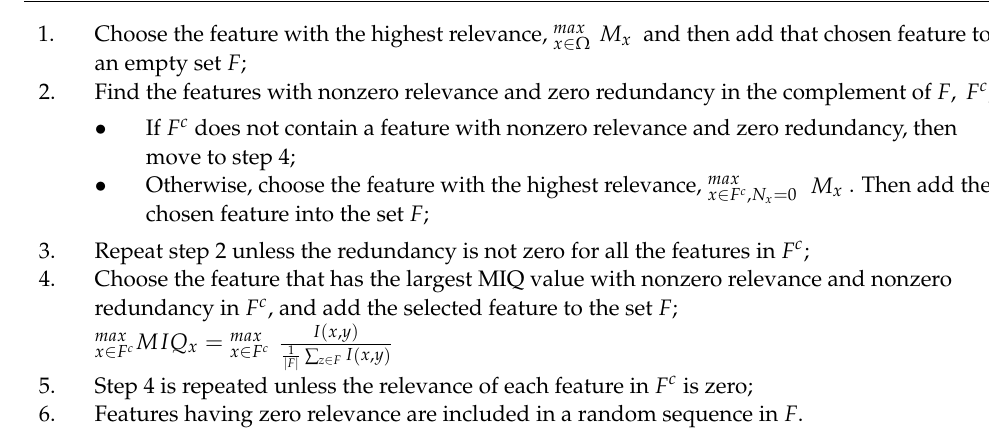
Algorithm 1 MRMR Algorithm—Pseudocode for optimal features